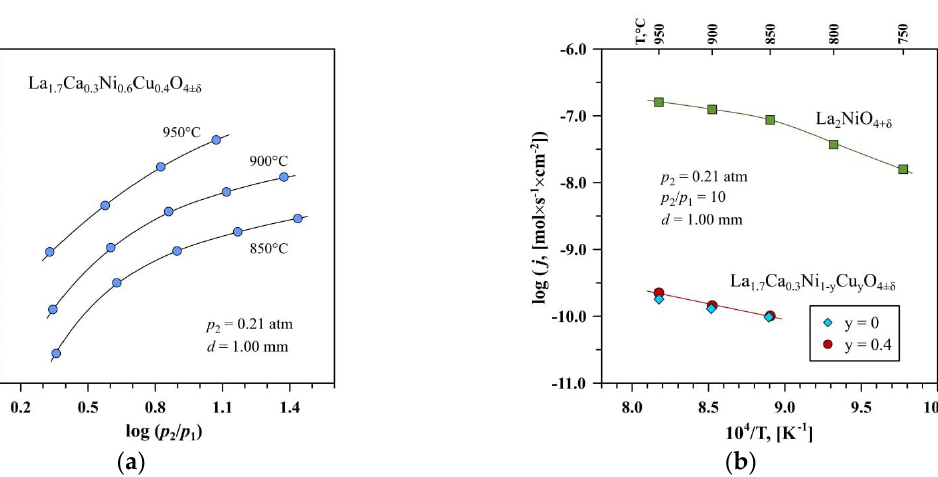
Figure 5. ( a ) Dependencies of the oxygen permeation fluxes through the La 1.7 Ca 0.3 Ni 0.6 Cu 0.4 O 4+δ ceramic membrane on the pO 2 gradient at 850 – 950 °C, and ( b ) Temperature dependences of the oxygen permeation fluxes through the La 1.7 Ca 0.3 Ni 0.6 Cu 0.4 O 4+ δ and La 1.7 Ca 0.3 NiO 4+δ membranes under the fixed pO 2 gradient. The data on the undoped La 2 NiO 4+δ sample are taken from [65]. The suppression of oxygen ionic transport in La 1.7 Ca 0.3 Ni 1 − y Cu y O 4+ δ should be